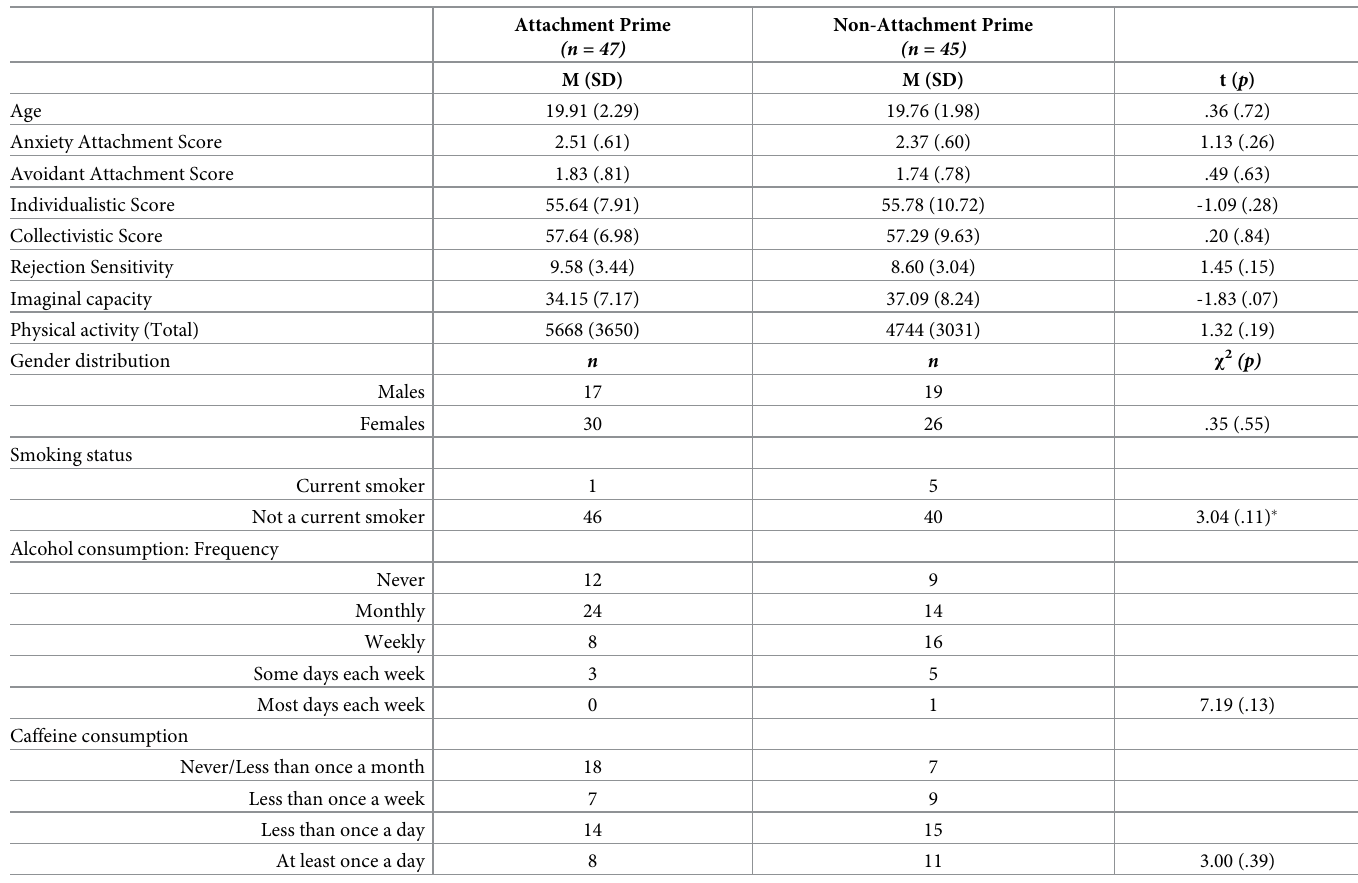
Table 1. Participant